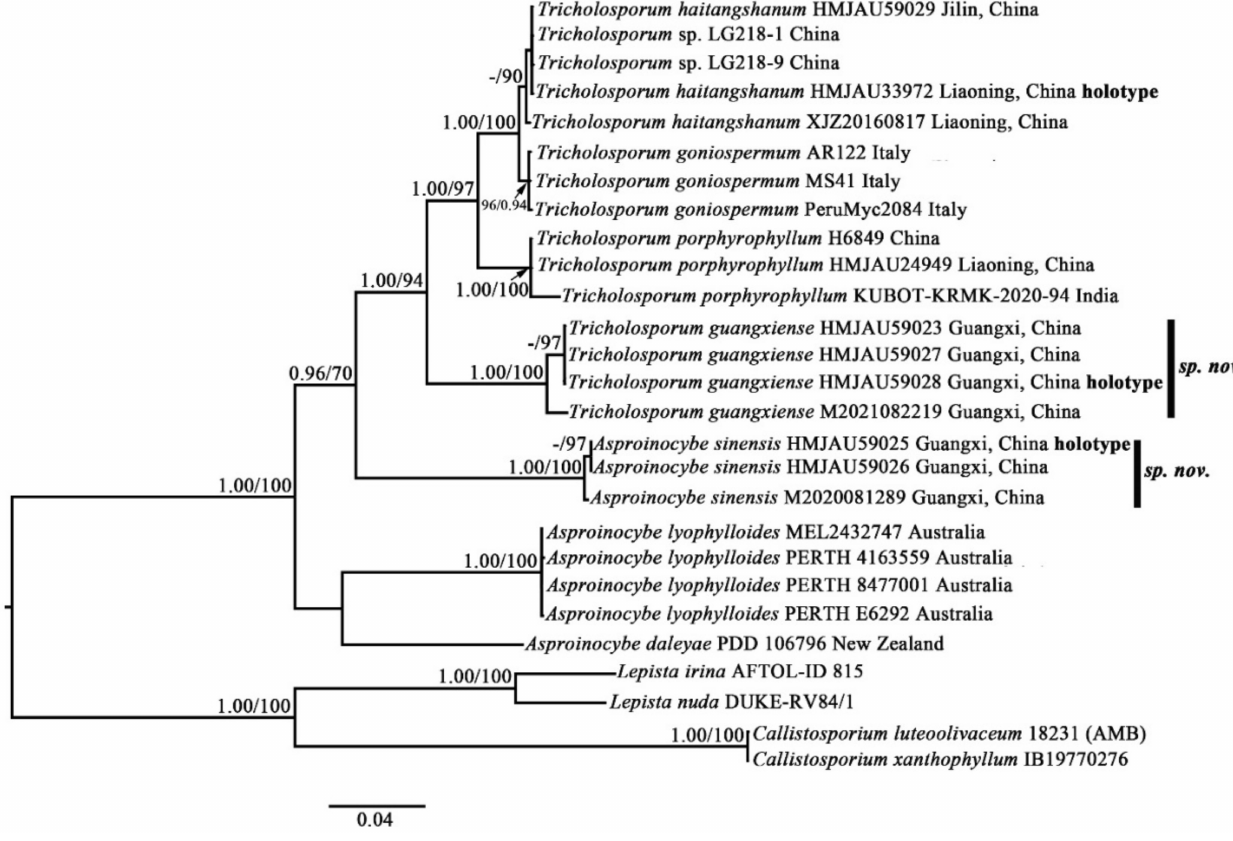
Figure 2. Phylogenetic tree inferred from partial ITS + LSU sequences showing phylogenetic relationships of Asproinocybe sinensis and Tricholosporum guangxiense within genus. Bayesian inference (BPP ≥ 0.90) and maximum likelihood support values (ML ≥ 70) are shown